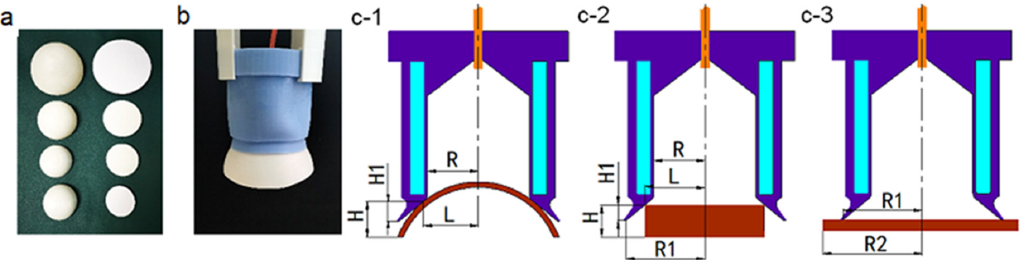
Figure 9. ( a ) Experimental objects for adsorption experiment of the cylindrical soft actuator. ( b ) The state of adsorbing an experimental object using the cylindrical soft actuator. ( c-1 ) Cylindrical soft actuator adsorbs a curved surface. ( c-2 , c-3 ) Cylindrical soft actuator adsorbs flat surfaces.